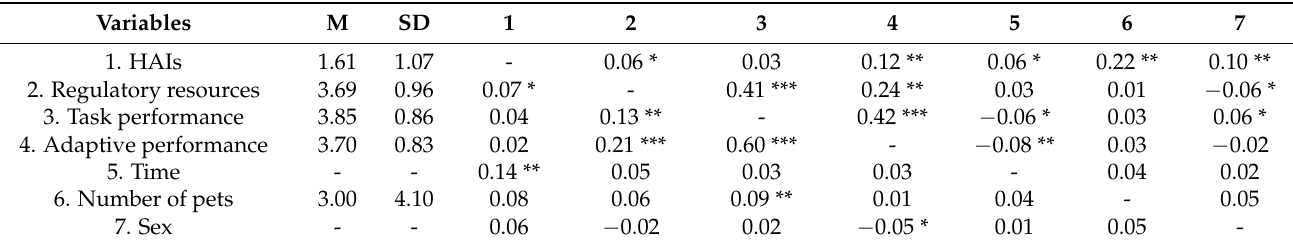
Table 1. Means, standard deviations, and between-and within-person level